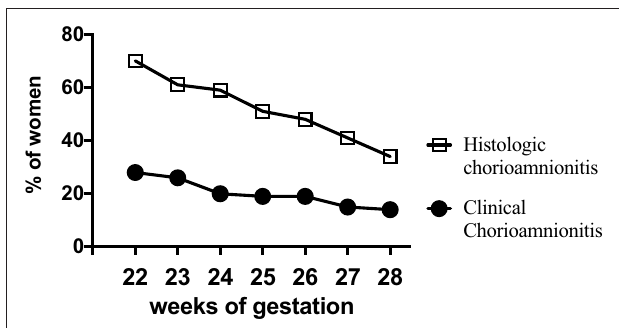
FIGURE 2 | Chorioamnionitis during second trimester. Higher documentation of histologic vs. clinically diagnosed chorioamnionitis in the same mothers whose Infants were born at 22–28 weeks Gestational Age (GA) in the NICHD funded Neonatal Network database (2003-2007). Also note that chorioamnionitis is more frequently diagnosed at earlier gestations (inverse correlation of gestational age with incidence of chorioamnionitis). Adapted from Stoll et al.